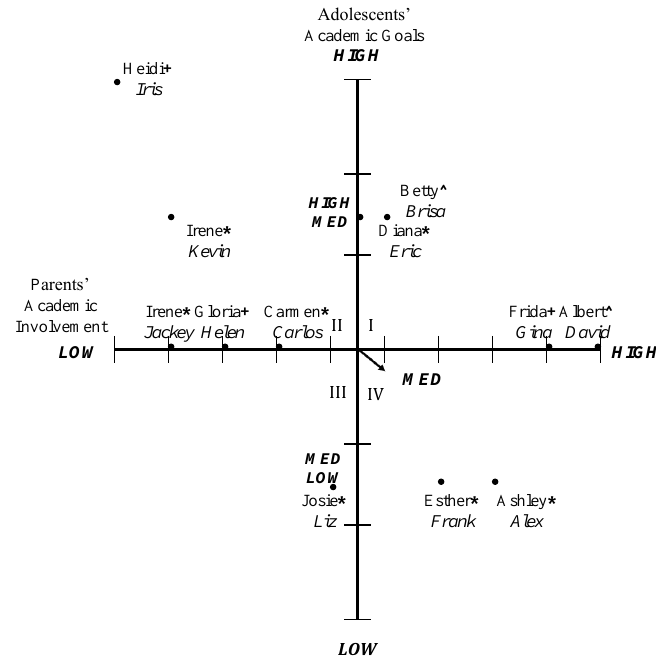
Figure 1. Parents’ academic involvement and adolescents’ academic goals pre-program. Adolescent pseudonyms are in italics. Parents education level: * = 6th grade or less; + = high school; ˆ = graduated college / university. Quadrant I, four parents reported medium to high parental involvement and their adolescents reported medium to high academic goals. Quadrant II, five parents reported low to medium parental involvement and their adolescents reported medium to high academic goals. Quadrant III, one parent reported low to medium parental involvement and their adolescent reported low to medium academic goals. Quadrant IV, two parents reported medium to high parental involvement and their adolescent reported low to medium academic